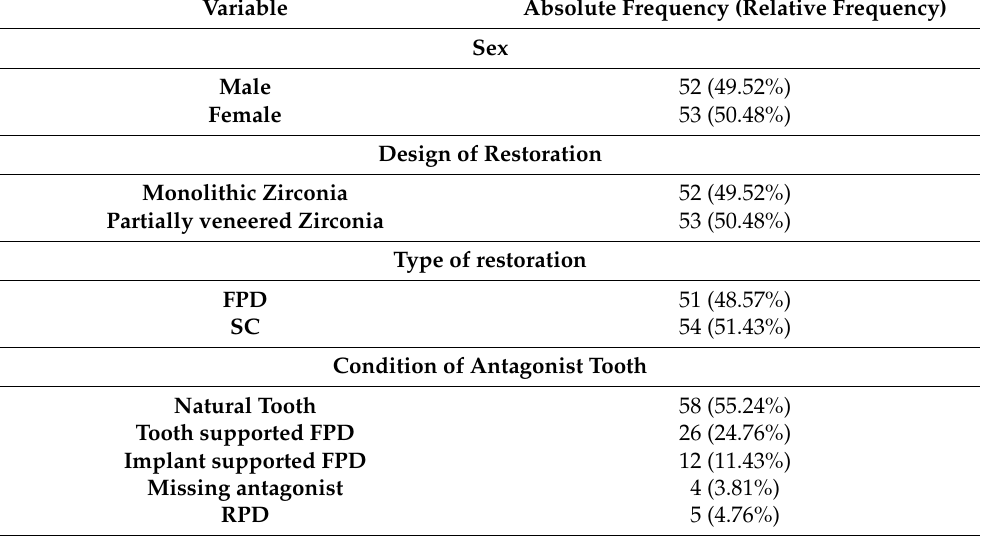
Table 1. Characteristics of the sample.